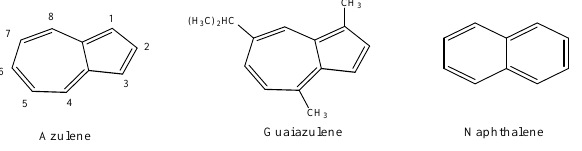
Figure 2: Chemical structures of azulene, guaiazulene and naphthalene Azulene and its alkyl derivative guaiazulene, 1,4- dimethyl-7-isopropylazulene and its structural isomer naphthalene (Figure 2) are the simplest PAHs. Azulene and its derivative are popular ingredients in beauty, cosmetic, skin, and body care products [56]. The photomutagenicity of azulene and guaiazulene in Salmonella typhimurium TA98, TA100 and TA102 was determined by irradiation with UVA and visible light. Both azulene and gauiazulene exhibited photomutagenicity on TA102. Azulene